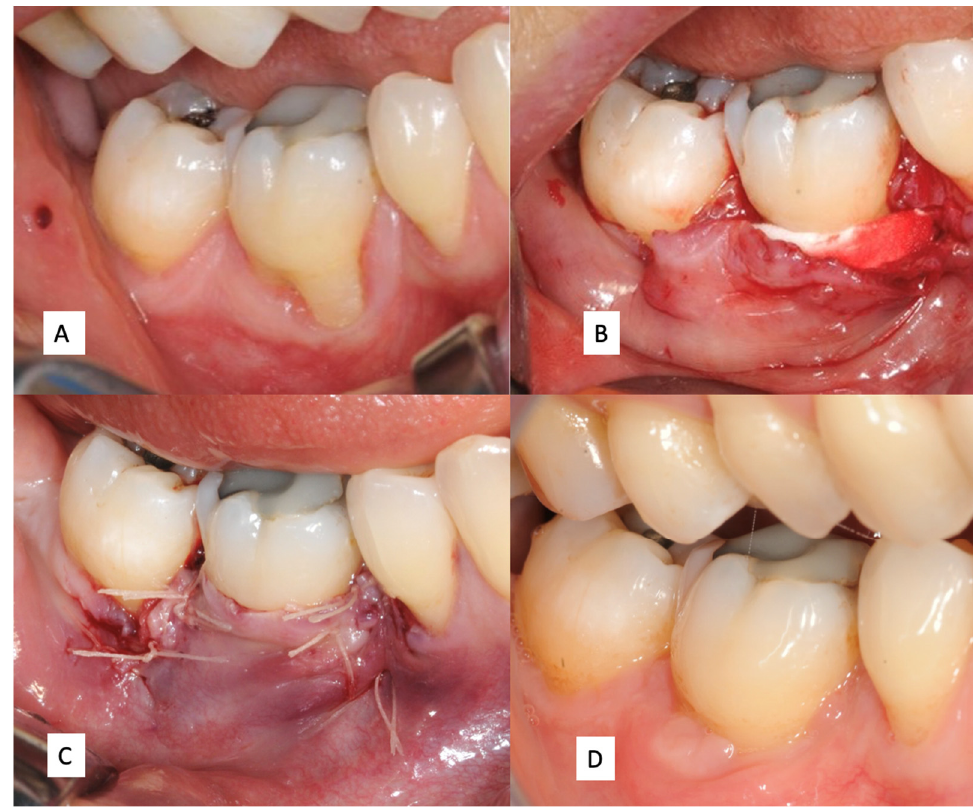
Figure 1. ( A ) Mucogingival defect of the first mandibular molar; ( B ) insertion of the xenogeneic collagen matrix; ( C ) flap suture; ( D ) healing of the surgical site after 6 months. collagen matrix; ( C ) flap suture; ( D ) healing of the surgical site after 6